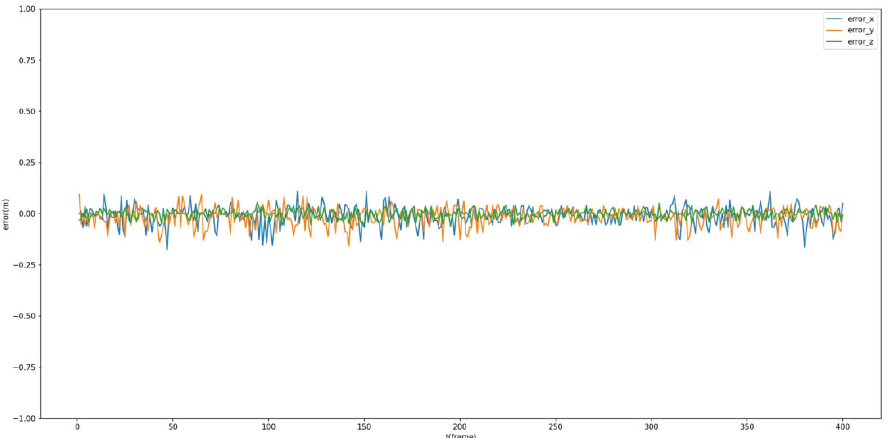
Figure 13. Error throughout the mission time.